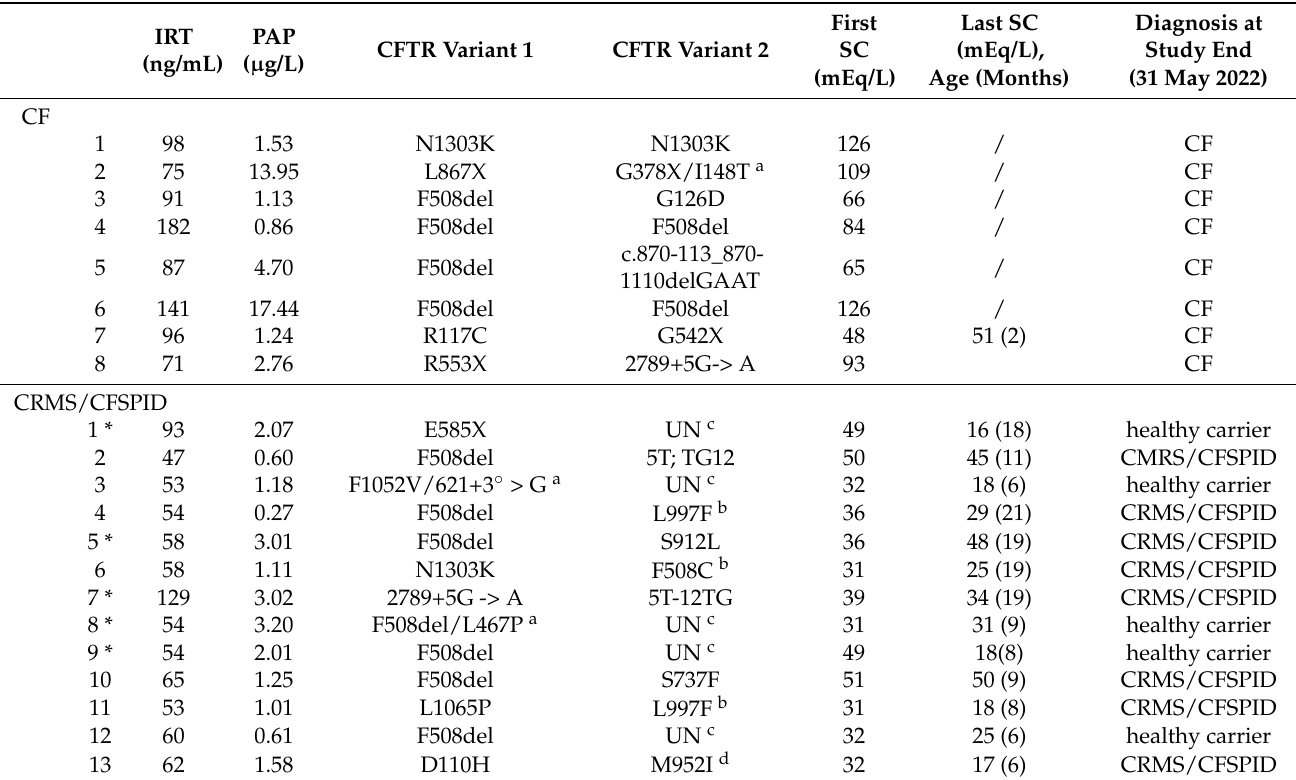
Table 1. Genotypes; IRT, PAP, and sweat chloride values and final diagnosis of subjects with CRMS/CFSPID and CF diagnosis.